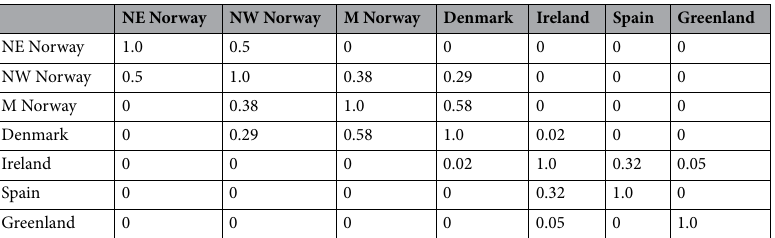
Table 2. Overlap in area use during the ocean migration between Atlantic salmon tagged in seven different areas, based on overlap in population-specific residency distributions. The values in the table represent Bhattacharrya’s affinity, which can be interpreted as proportion overlap (1 = total overlap, 0 = no overlap). Data from salmon tagged in Iceland were not included due to a small sample